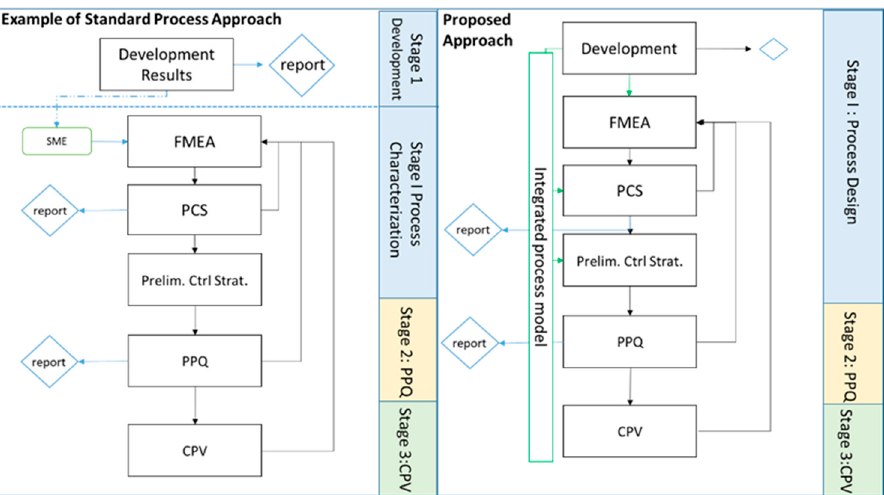
Figure 1. Example of a standard characterization workflow ( left ) vs. the proposed IPM-based workflow ( right ). Three aspects are of note. First, an algorithmic link between development and PCS can iteratively add data to an integrated process model. Second, the baseline FMEA severity ranking and preliminary control strategy are statistically underpinned. Third, since the FMEA and preliminary control strategy results are automatically generated in parallel, it removes linear effort in task completion. These activities then supplement the process performance qualification (PPQ) and continued process verification (CPV) stages of validation.